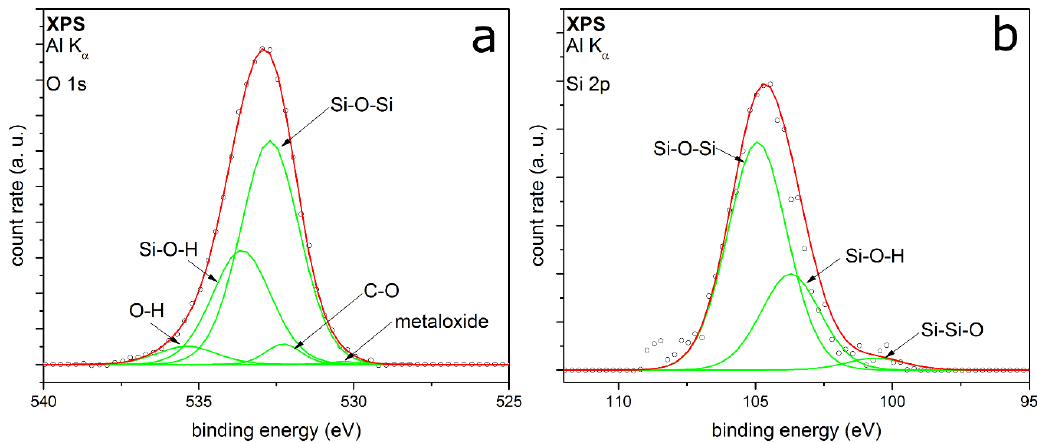
Figure 4. XPS detail spectra of ( a ) O 1s and ( b ) Si 2p of Au metal particles coated with TEOS as precursor.